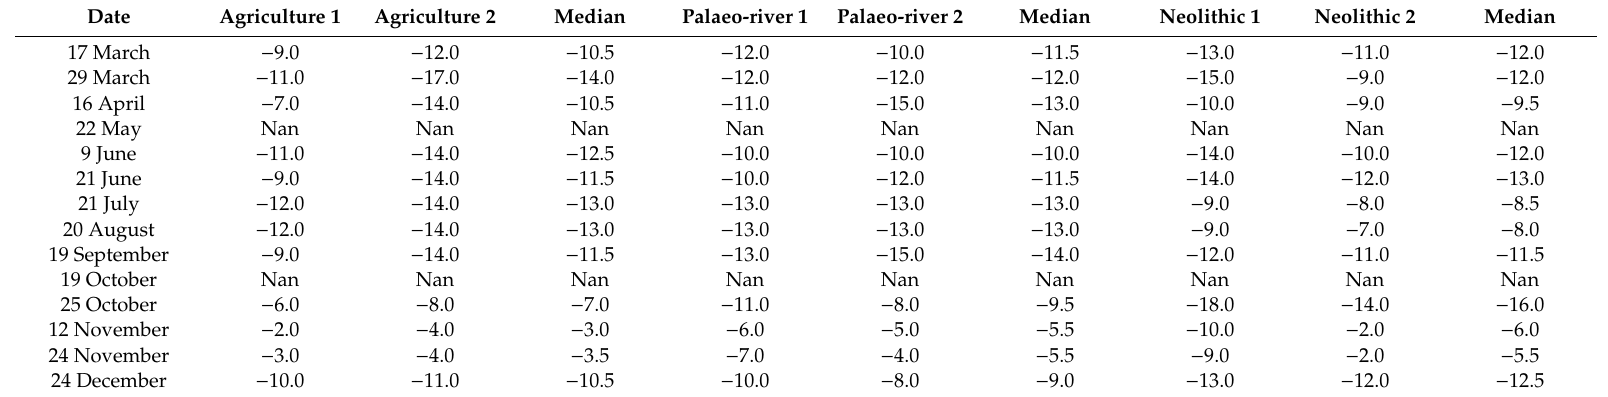
Table A1. Backscatter values for the Sentinel 1 2019 Sigma0-VV ascending pass direction.